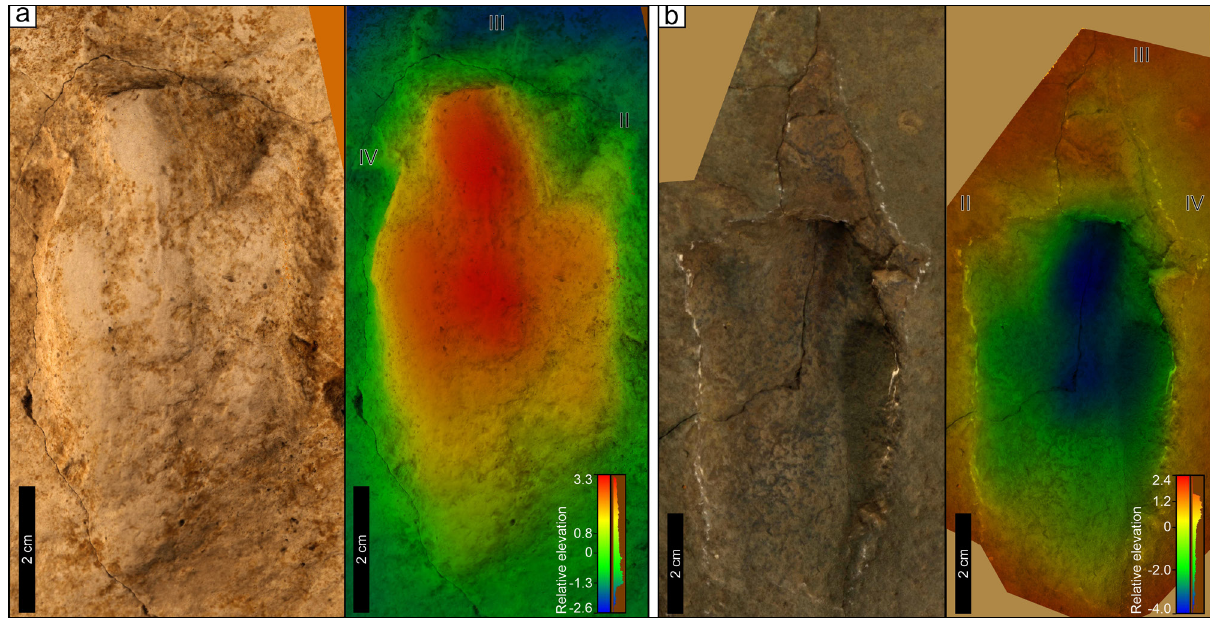
Figure 5: Grallator tracks from the Clarens Formation in Lesotho. Left image: orthophoto derived from photogrammetric modelling; right image: false-colour depth model generated using CloudCompare version 2.11.3 (dark red is the highest point, dark blue the lowest). (a) Grallator (Paragrallator) matsiengensis ( 6,7 figure 128, LES 283) from Matsieng (Zone B/5). This broken, plaster-of-Paris cast is the only replica of the lost holotype. (b) Grallator molapoi ( 6,7 LES 288, holotype) from Leribe-Molapo (Zone B/6). Both specimens are housed in the Ellenberger Collection at the University of Montpellier (France). See Supplementary table 5 for their morphometric measurements and https://doi.org/10.6084/m9.figshare.13007240 for their photogrammetric models. Roman numerals I–IV denote